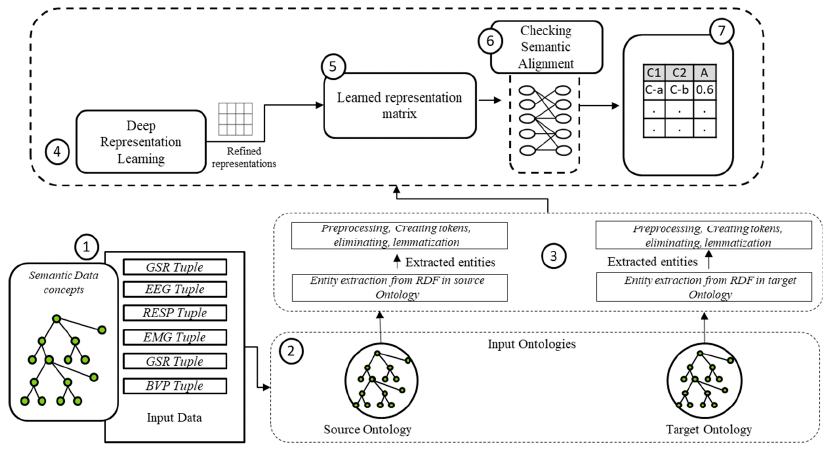
Figure 9. Stepwise semantic alignment process.